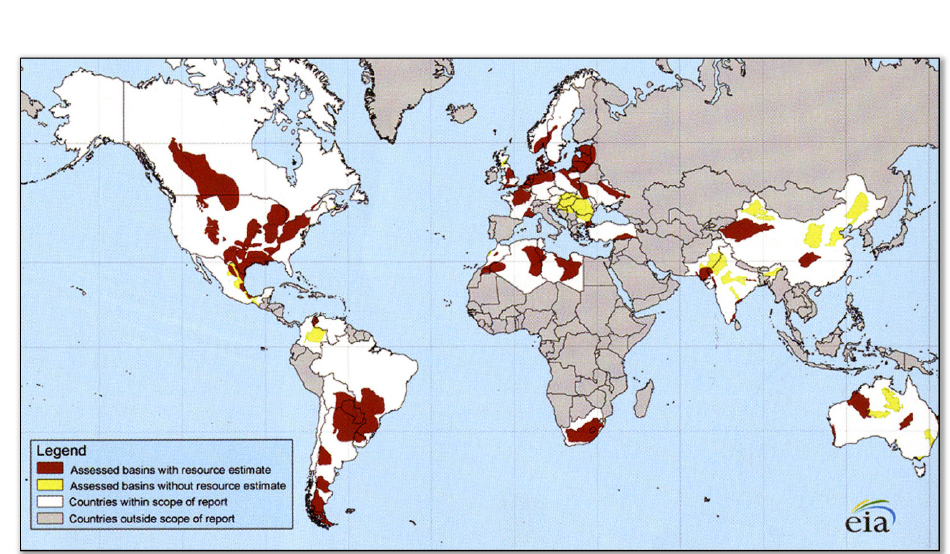
Fig. 10. – Unconventional basins in the world (from U.S. EIA,